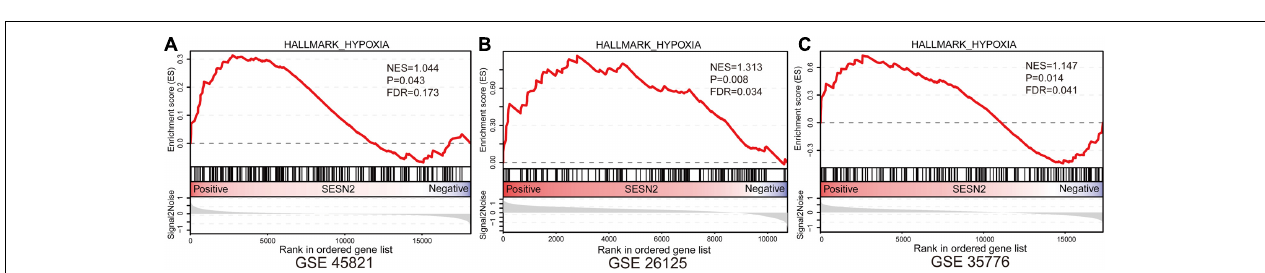
FIGURE 5 | Gene Set Enrichment Analysis results of hypoxia gene set for SESN2 high-expression samples vs. SESN2 low-expression samples in normal fetal or adult heart tissues from (A) GSE45821, (B) GSE26125, and (C) GSE35776 datasets. NES, Normalization enrichment score. FDR, false discovery rate.